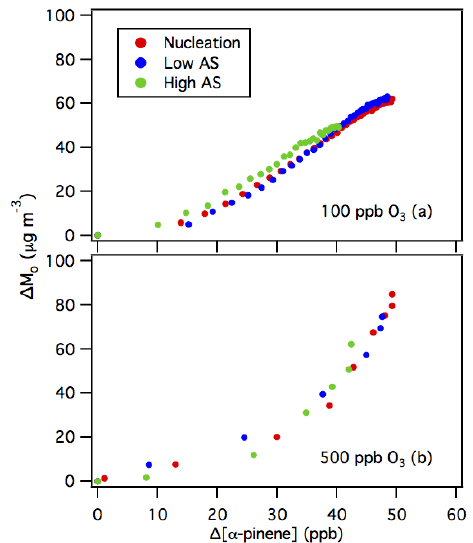
Figure 4. Ten-minute-averaged SOA mass yields over the course of an α -pinene ozonolysis experiment as a function of initial total AS seed surface area concentration for the (a) 100ppb O 3 experiments, and (b) 500ppb O 3 experiments. Symbol color indicates the SOA mass concentration and symbol size indicates the time after O 3 is injected into the chamber. The × symbols are the SOA mass yields at peak SOA growth obtained from the experimental data. The y - axis error bars represent the uncertainty in the SOA mass yield at peak SOA growth, which originates from the α -pinene injection and the aerosol volume concentration measured by the SMPS at peak SOA growth (1 standard